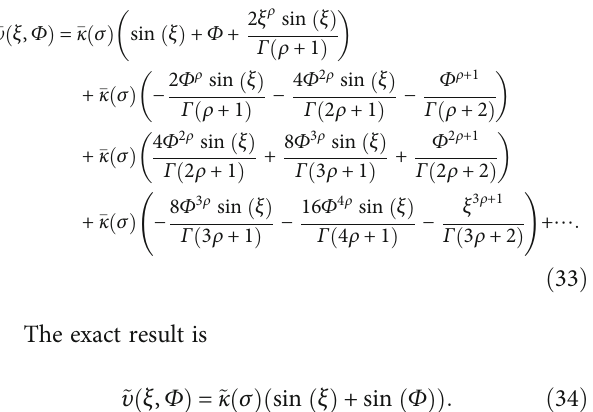
In Figure 4, fi rst two-dimensional fuzzy upper branch graph and second bottom branch graph of an analytic series result of various fractional of ρ . In Figure 5, fi rst two- dimensional fuzzy upper branch graph and second bottom branch graph of an analytic series result of various fractional of ρ with respect to time. In Figure 6, graph depicts a two- dimensional fuzzy upper and bottom branch graph of an analytic series result with respect to space and time in exam- ple